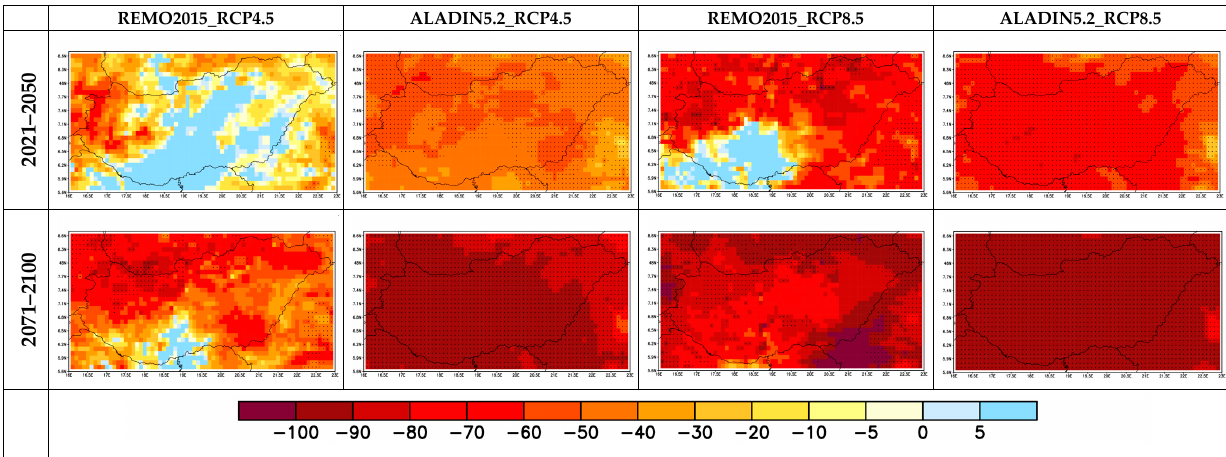
Figure 17. Relative change in the annual number of extremely cold days (days) in Hungary for 2021–2050 and 2071–2100 based on the ALADIN5.2 and REMO2015 simulations. Reference period: 1971–2000. We add that over lakes and rivers, the magnitude of the change in the indices sharply differed from that of the neighbouring areas (much smaller changes or changes with the opposite sign), which might be explained by the lack of a lake module in REMO2015. It considers water surface temperatures by applying the nearest sea surface temperature to all inland water surface points. This topic was covered earlier by Suga et al.